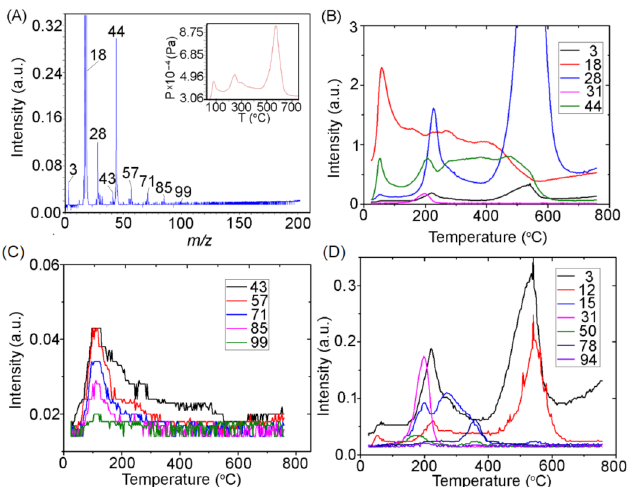
Figure 7. Thermal decomposition of G/CeO 2 (0.6 mmol/g); mass spectra at 120 ◦ C and vapor pressure measured as a function of temperature for the G/CeO 2 sample ( A ); TPD curves for ions with m / z 3, 18, 28, 31, and 44 ( B ); for ions with m / z 43, 57, 71, 85, and 99 ( C ); for ions with m / z 3, 12, 15, 31, 50, 78, and 94 ( D